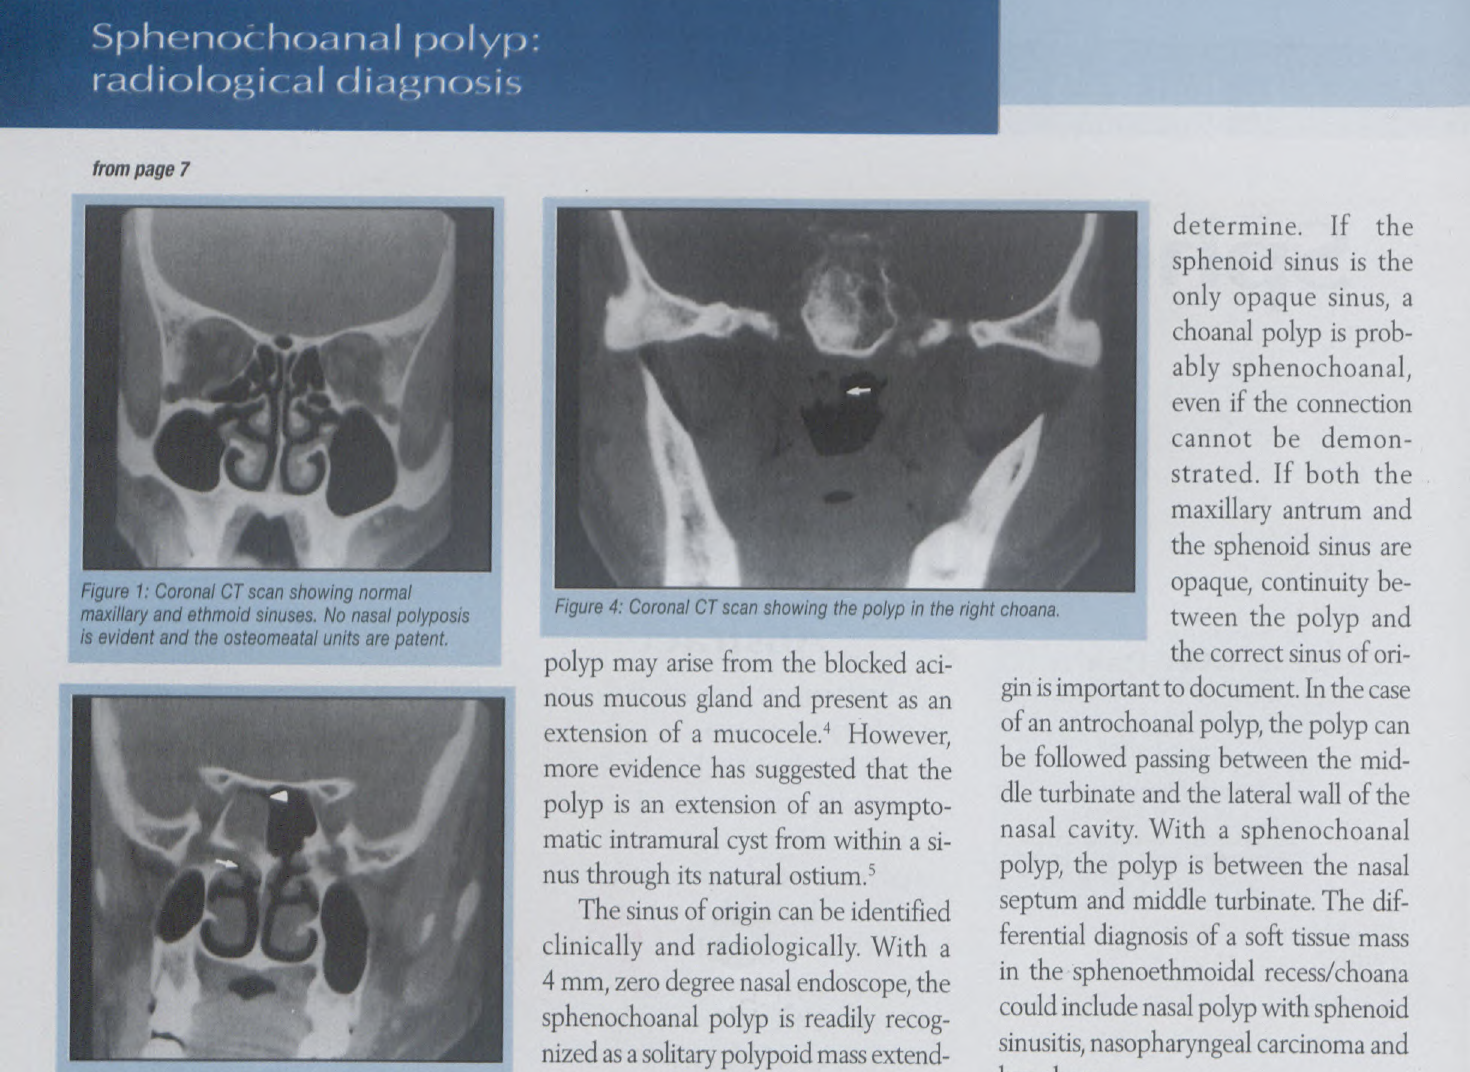
Figure 2: Coronal CT scan through the posterior maxillary sinuses which are clear. A soft tissue opacity with a convex upper margin is seen in the sphenoid sinus (arrowhead). There is soft tissue in the sphenoethmoldal recess representing the stalk of the polyp (arrow).